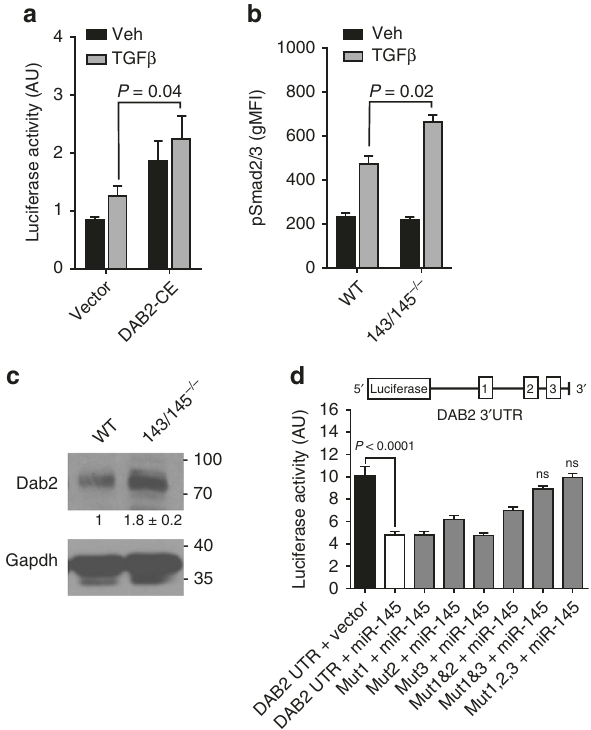
Fig. 3 Loss of miR-143 and miR-145 activates the TGF β /Dab2/ Smad3 signaling axis. a Measurement of luciferase activity after transfection of 3TP-LUX, a luciferase reporter containing TGF β -responsive elements, into 293T cells constitutively expressing DAB2 (DAB2-CE) and stimulated with vehicle (Veh) or 5 ng/ml TGF β . Data are expressed as arbitrary units (AUs, mean ± SEM, n = 3). b Phosphorylation of Smad2/3 (pSmad2/3) in lineage-negative marrow cells of wild-type (WT) and miR- 143/145 − / − mice stimulated with vehicle or 5 ng/ml TGF β by intracellular fl ow cytometry. Data are expressed as geometric mean fl uorescence intensity (gMFI, mean ± SEM, n = 3). c Western blot of Dab2 in WT and miR-143/145 − / − Lin − marrow isolated by immunomagnetic negative selection. Densitometry data were normalized to Gapdh and are presented as a ratio relative to vector (mean± SEM, n = 7, P = 0.001)). d Luciferase activity after co-transfection with empty vector or miR-145 overexpression construct with the WT or seed site-mutated 3 ′ -UTR of DAB2 inserted downstream of a luciferase reporter (mean ± SEM, n =